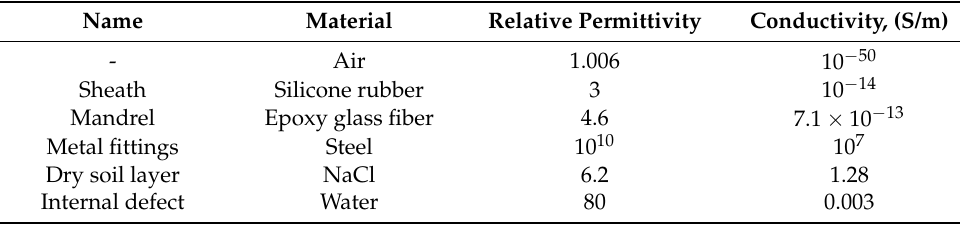
Table 2. Physical parameters of each